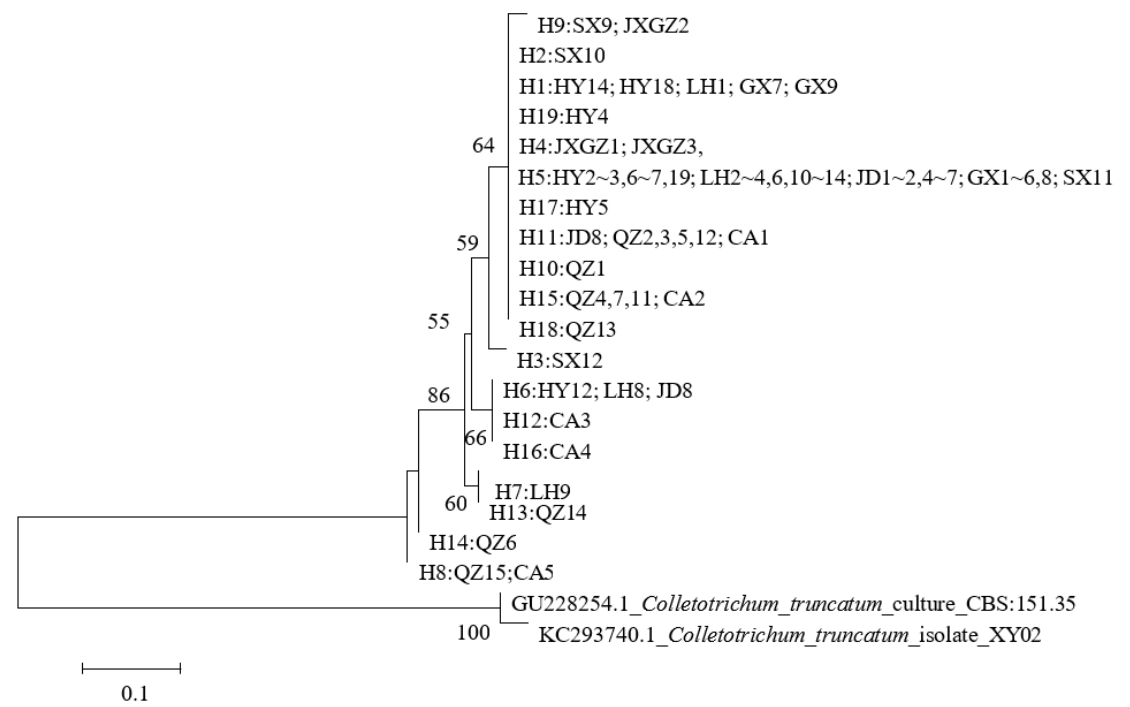
Figure 3. The neighbour-joining tree of the GAPDH sequences of Colletotrichum gloeosporioides and representative sequences from Colletotrichum truncatum as an outgroup.